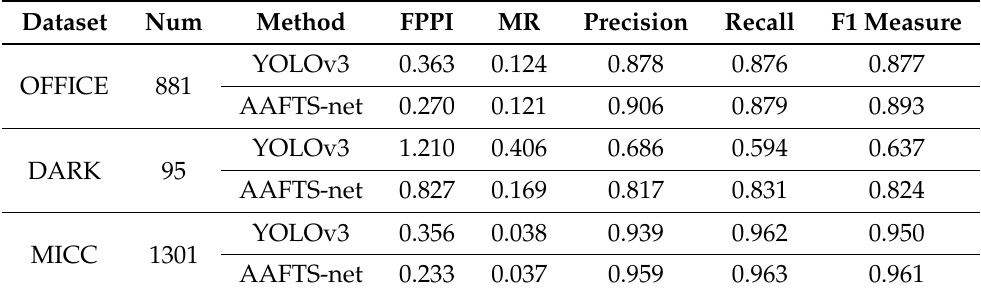
Table 2. Comparison of the results of AAFTS-net and YOLOv3 on OFFICE, DARK and MICC.